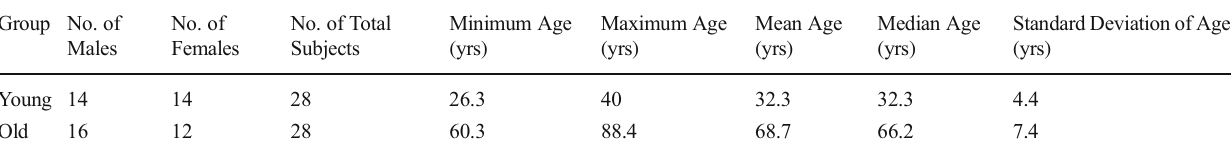
Table 1 Demographic detail of the successfully-tested younger and older driver groups Group No. of